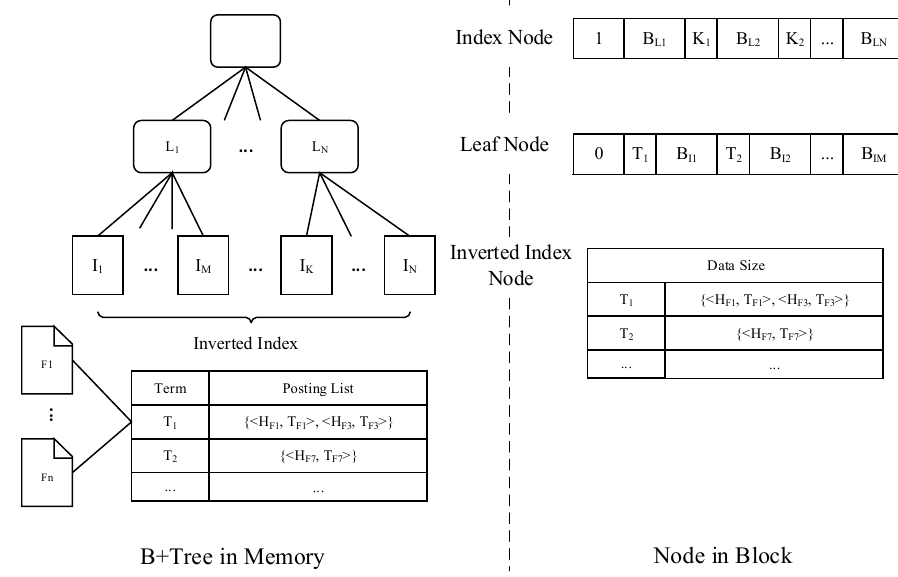
Figure 2. The structure of